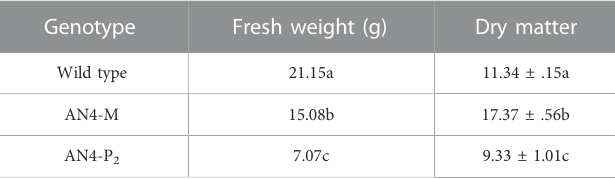
TABLE 1 Fresh and dry matter of MicroTom wild type, AN4-M and AN4-P 2 plants.